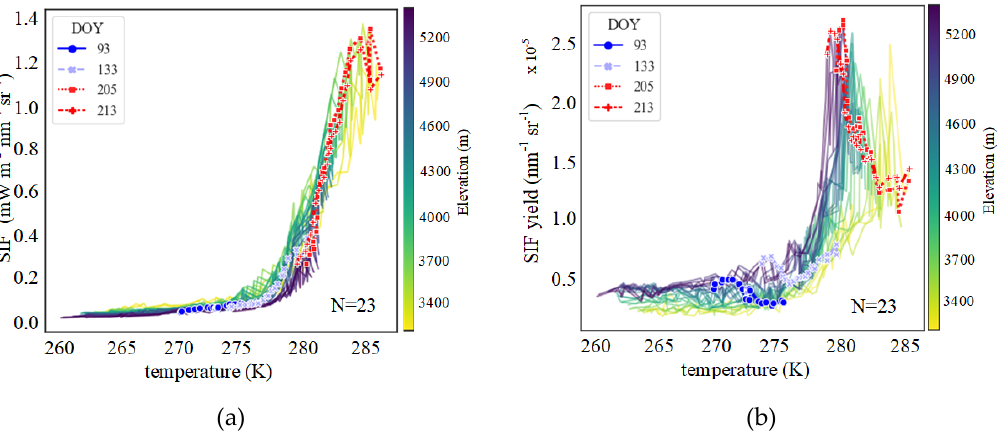
Figure 4. Temperature responses of ( a ) SIF and ( b ) SIF yield at different altitudes at seasonal scales. Observations from DOY 93 (April, early regreening period at late spring), 133 (May, early regreening period at late spring), 205 (July, the peak of summer growth period), and 213 (August, the late summer growth period) are marked.